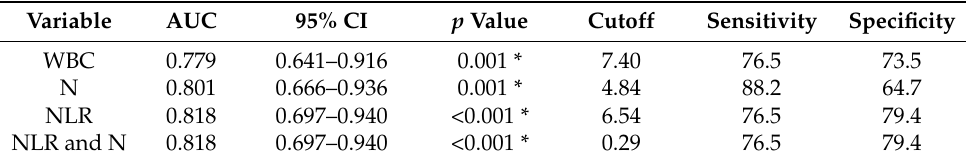
Table 6. Receiver operating characteristic curves of the variables as early predictor after propensity score-matched analysis.